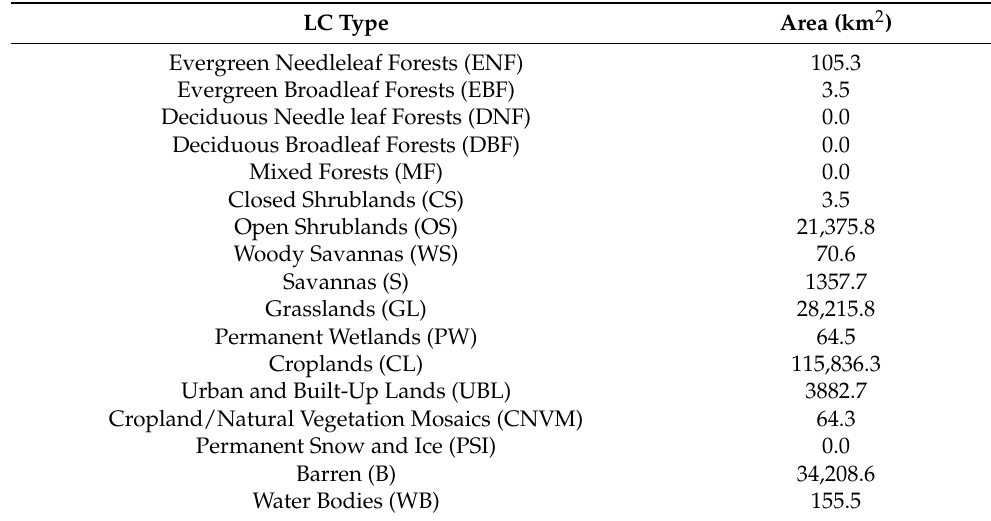
Table 2. Land-cover types of Punjab, Pakistan, that were identified from MODIS (MCD12Q1) images using IGBP classifications [47,48].